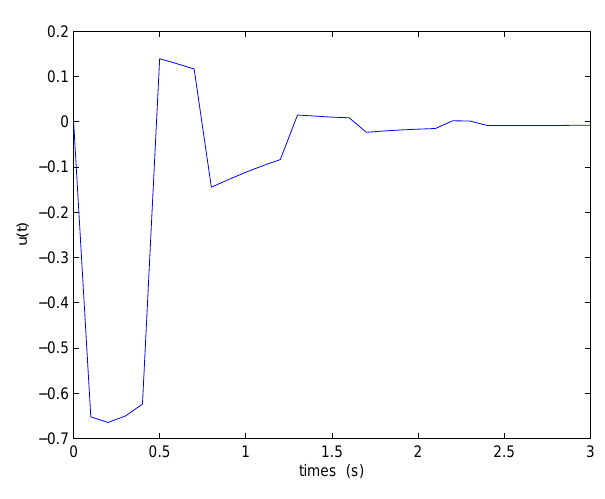
Figure 5. The control